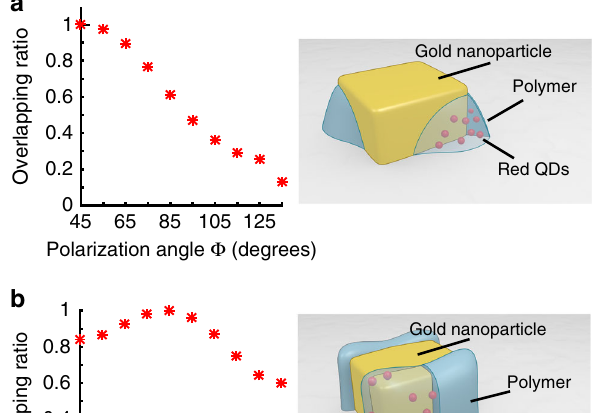
Fig. 7 Overlap integral ratio. Computed spatial overlap integral η de fi ned in Eq. (4), between the local excitation fi eld and the active medium as a function of the incident polarization angle ϕ for three different hybrid nanosources. The incident fi eld is linearly polarized, λ = 405 nm. a Au nanocube with polymer lobes along the diagonal direction, ϕ = 45°. b Au nanocube with polymer deposits at cube faces, ϕ = 0°. c Hybrid Au nanodisk with polymer lobes along ϕ =